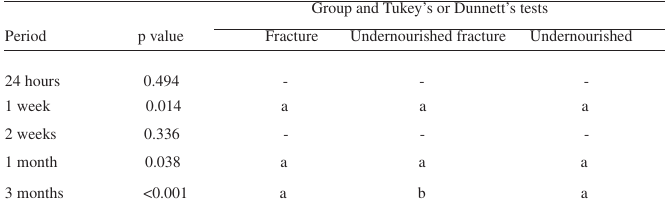
FIGURE 3 – Mean values (degrees) of Angle Å of all the groups according to the experimental period. TABLE 1 – Significance of the analysis of variance of angle Å